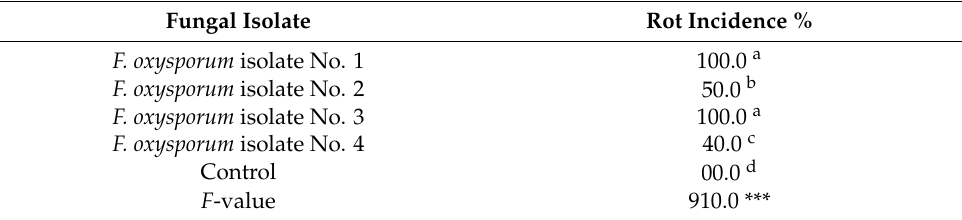
significantly different at p < 0.05 according to Duncan’s multiple range test.